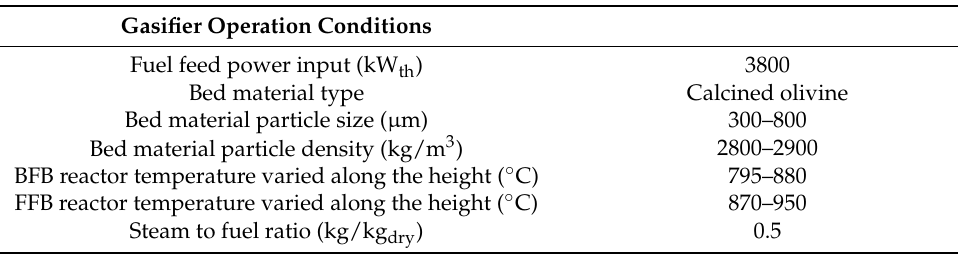
Table 1. Nong Bua DFB steam gasifier operation conditions.